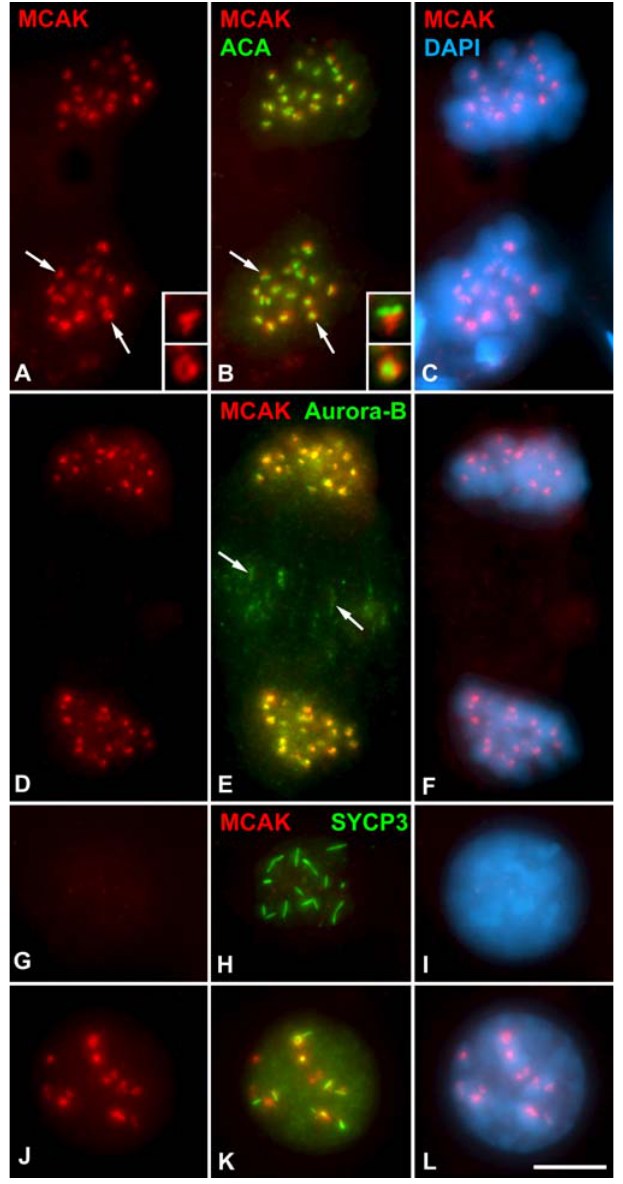
Figure 3. MCAK Is Lost from Centromeres at Telophase I but Is Again Detected at Centromeres by Late Interkinesis MCAK is labelled in red and kinetochores (B), Aurora-B (E), and SYCP3 (H,K) are labelled in green. In merged images colocalisation regions appear in yellow. DNA appears in blue. All images are z-projections of several focal planes throughout the spermatocytes shown. (A–C) Anaphase I. The MCAK labelling is detected in side views of the centromere as a T-shaped signal below the closely associated sister kinetochores (top insets), or as a ring surrounding them in top views of the centromere (bottom insets). Arrows in (A) and (B) indicate the enlarged centromeres shown in insets. (D–F) Late anaphase I. MCAK and Aurora-B signals at centromeres colocalise. Aurora-B is also observed at the spindle midzone (arrows). (G–I) Early interkinesis nucleus. SYCP3 appears as thin bars in the nucleoplasm, while no MCAK labelling can be detected. (J–L) Late interkinesis nucleus. SYCP3 bars are still visible in the nucleus, and MCAK is again detected as small patches on heterochromatic chromocentres. Bar, 10 l